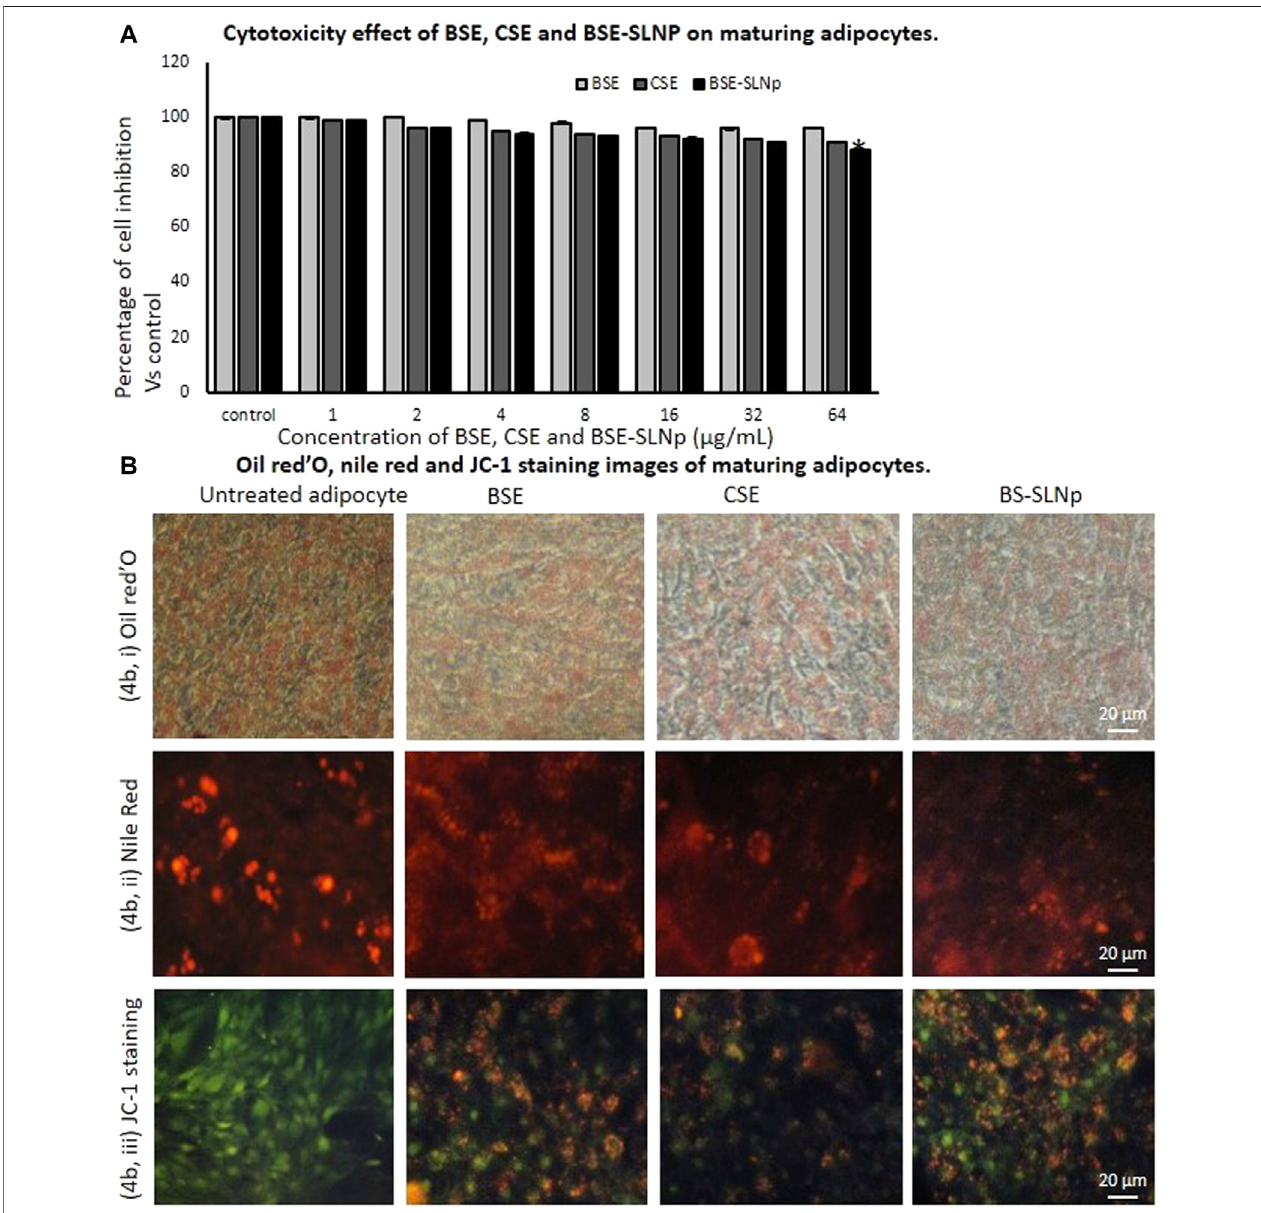
FIGURE4| Invitro cytotoxicityafter48 h (4A) ,OilRedO (4Bi) ,Nilered (4Bii) ,andJC-1 (4Biii) stainedmicroscopicimageanalysisofvehiclecontrol,BSE,CSE,andBSE-SLNp treated maturing adipocyte after 14 days. Each value is means ± SD ( n (cid:2) 6). * p ≤ 0.05 by comparison with vehicle control. In Oil Red O staining and Nile red staining, vehicle control showing hypertrophic adipocyte directly propositional to triglyceride storage. But in BSE-SLNp treatment shown controlled adipocyte maturation, less lipid accumulation, and less fl orescentstaining.BSE-SLNptreatedcellsshowingthehighestreductioncomparedtoBSEorCSE.JC-1 fl uorescenceimagesshowingmerged imagesoftheredandgreen signals of the dye, corresponding to JC-1 in J-aggregates vs. monomeric form. We found less J-aggregates and hypertrophic adipocyte in vehicle control. In BSE-SLNp treated adipocyte showing high J-aggregates directly representing active mitochondria (high MMP, Δψ m ).